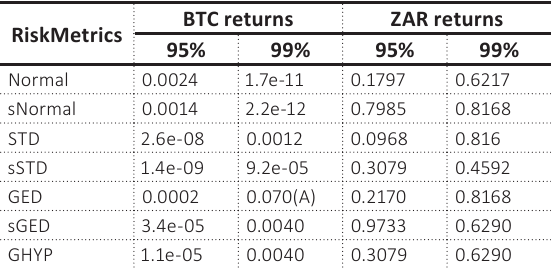
Table 6. Kupiec’s test p-values